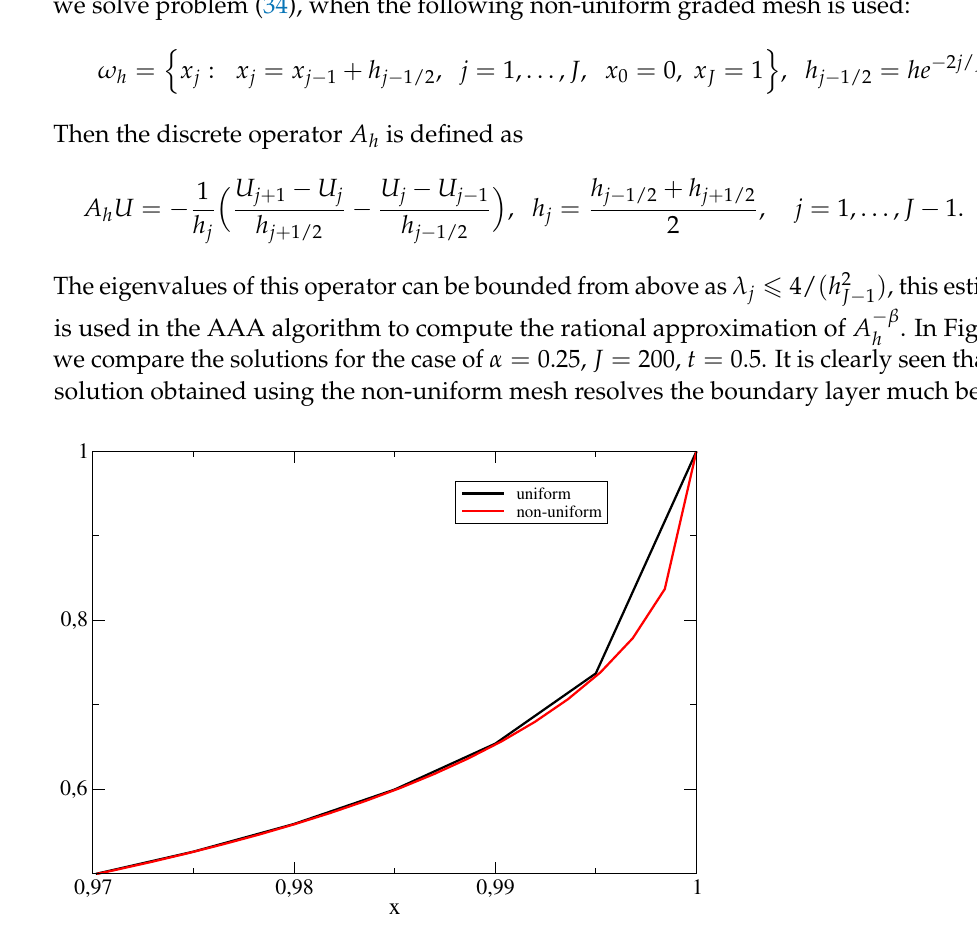
Figure 2. Distribution of the substrate at t = 0.5 for the fractional power parameter α = 0.25 in the cases of uniform and non-uniform